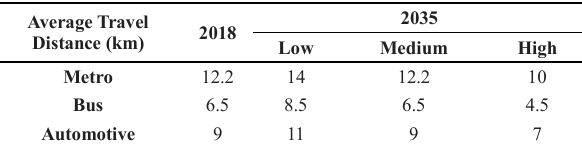
Table 6. Scenario setting of average travel distance